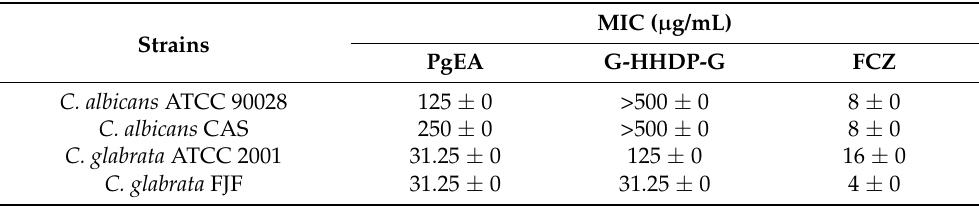
Table 4. MICs of PgEA, G-HHDP-G, and FCZ against Candida spp. The readings of cell